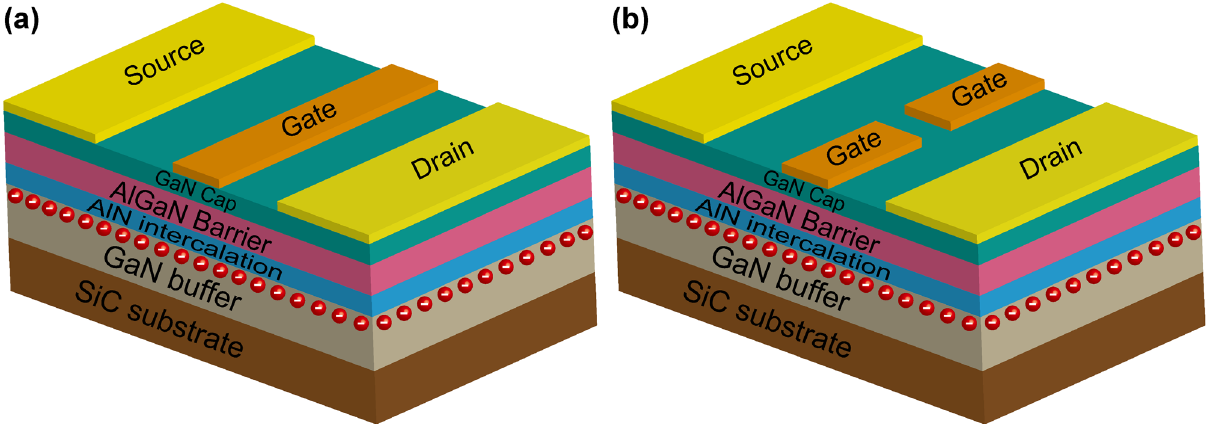
Figure 1. Schematic diagram of the structure of ( a ) normal device and ( b ) open-gate device. The figure was generated by Adobe Illustrate CC 2019 (https:// www. adobe. com/ cn/ produ cts/ illus trator.